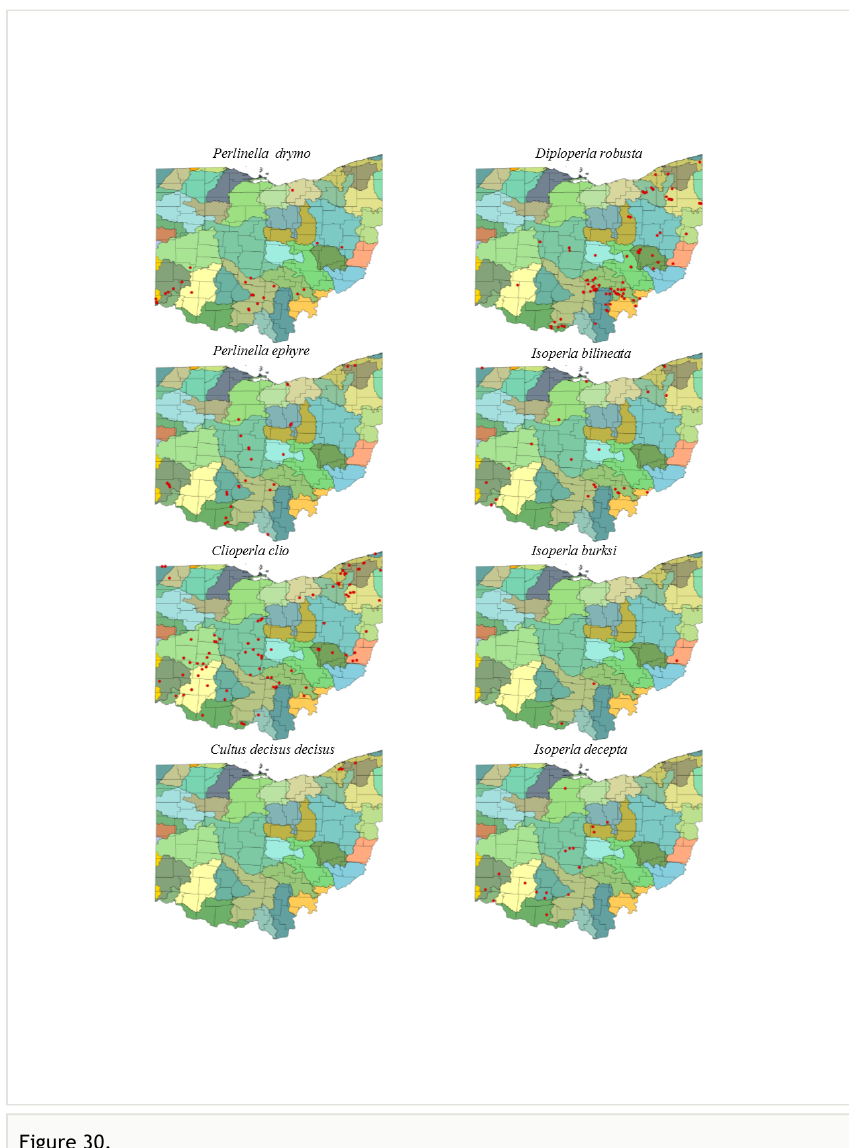
Figure 30. Distribution of Perlidae and Perlodidae in